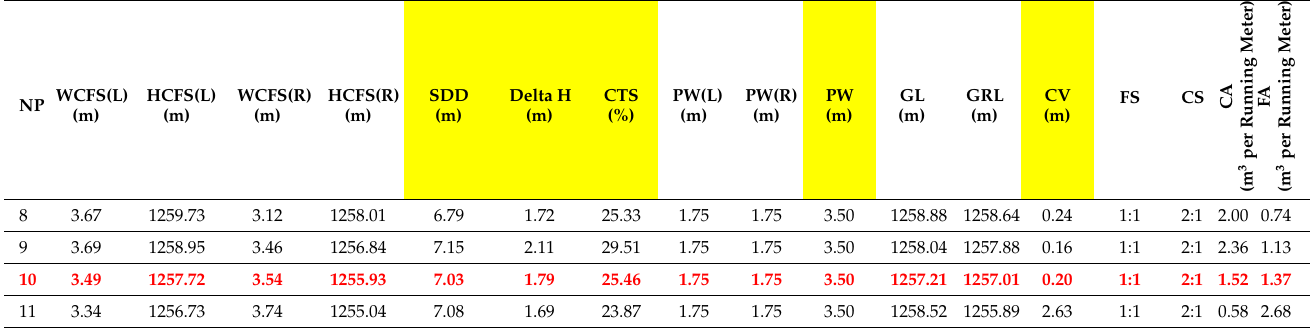
Table 2. Read/analyzed data on example of cross section profiles 8–11 for forest road “Mariˇci´ca vrh”.